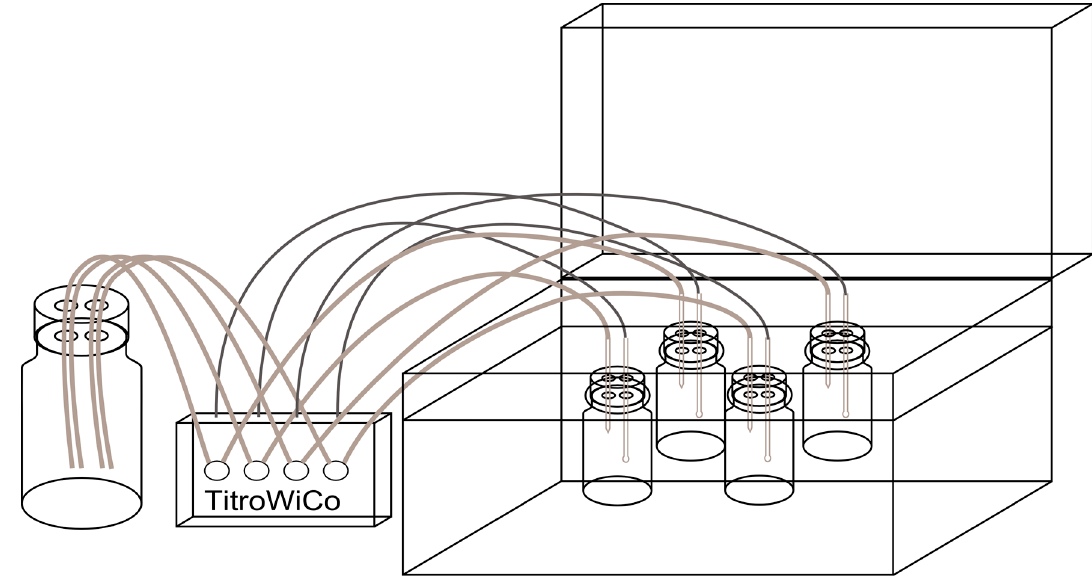
Figure 1 . Schematic diagram of the in vitro digestion model. Four food samples can be digested in parallel in the flasks on the right placed in a shaking water bath after the addition of the simulated digestive juices. The titrator on the left is filled with aqueous hydrochloric acid or sodium hydrogen carbonate and adjusts automatically to the right pH for the simulation of the stomach or small intestine digestion.